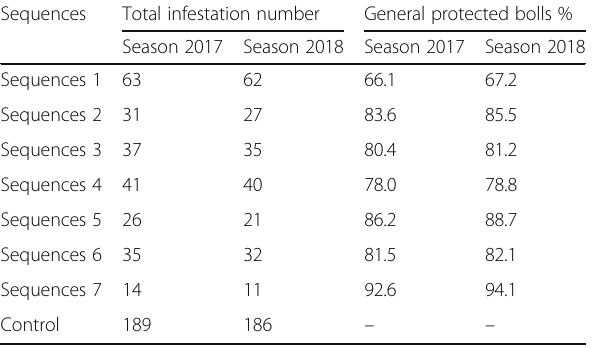
Table 6 Percentages of protected bolls in sequential treatments post-spray in two cotton seasons